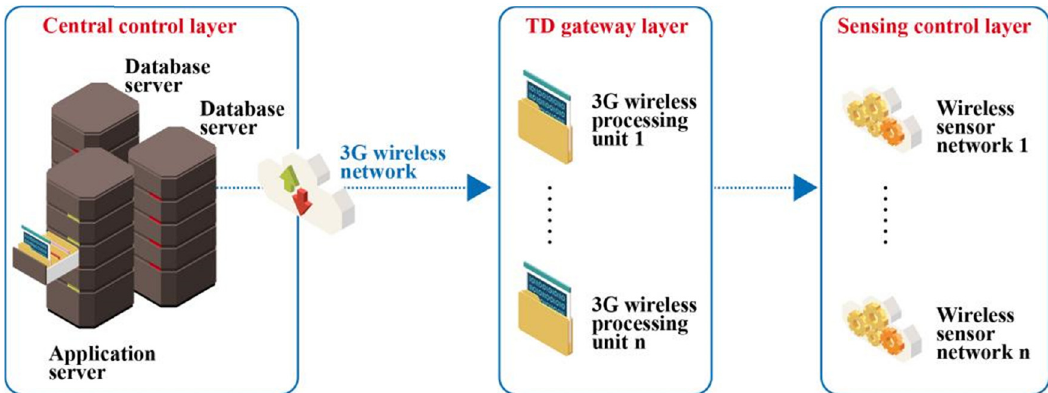
Figure 1: Bridge disturbance